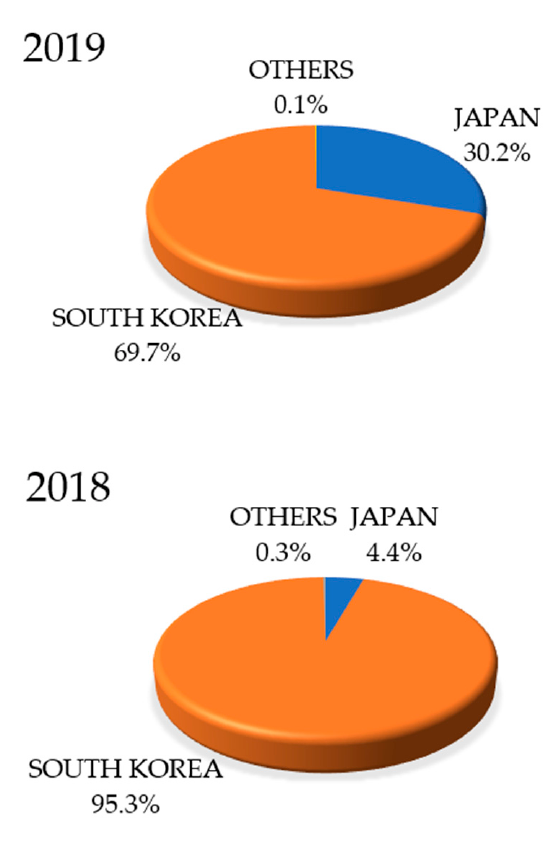
Figure 2. Proportion of importers of wood pellets from Thailand in 2018–2019 [29].